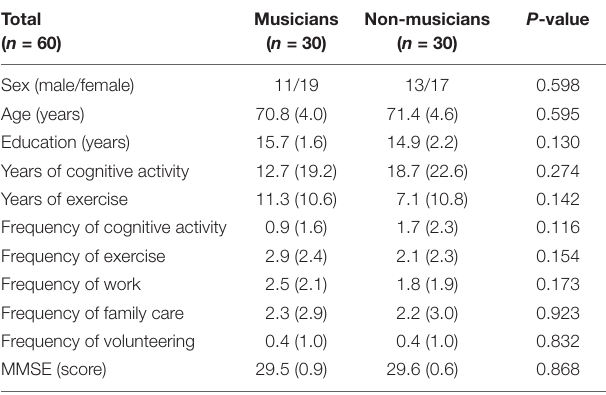
TABLE 1 | Demographics of musicians and non-musicians.